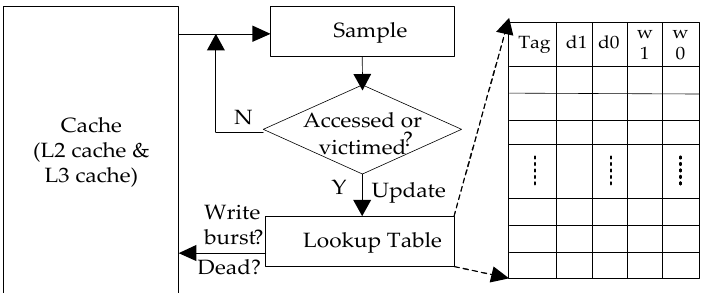
Figure 2. The method of counting cache accesses.